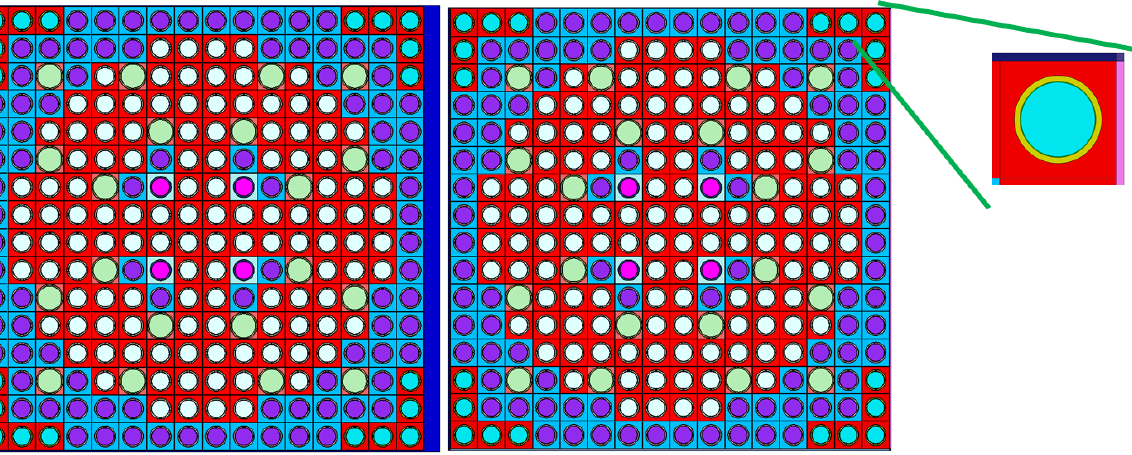
Figure 1. Lattice code models representing single FA: Left – explicit water gap modelling, Right – water gap modelling through equivalent water